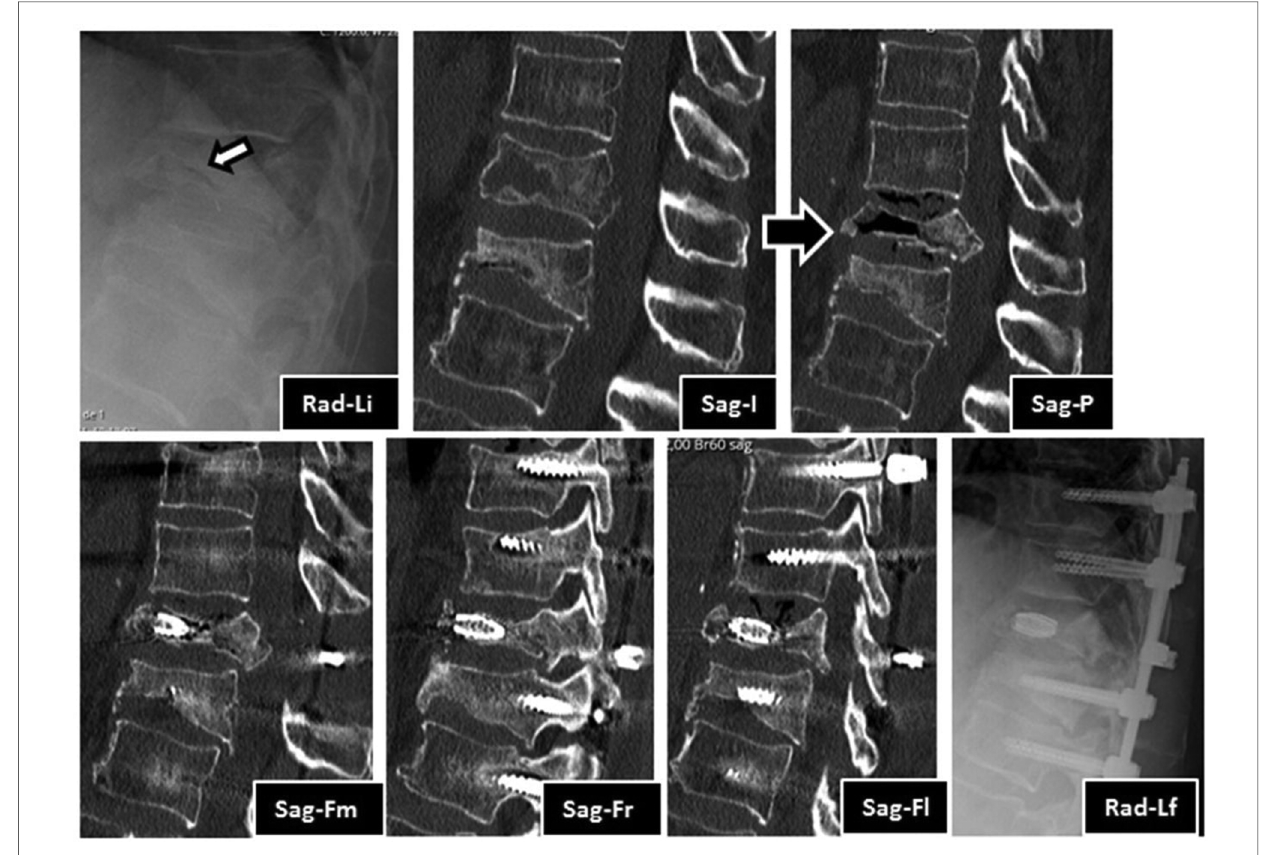
FIGURE 1 Imaging evolution of the clinical case in lateral view radiography images and sagittal CT sections: Rad-Li — initial radiograph in lateral view, showing T12 and L1 vertebral body fl atenning and extensive bone destruction at T12 (arrow); Sag-I — initial median sagittal view of computed tomography, showing acute T12 fracture and old L1 fracture. Note the extensive bone trabeculae destruction at anterior half of the vertebral body; Sag- P — Median sagittal view of tomography, showing T12 vertebral body pseudarthrosis with a large anterior intravertebral cleft and marked posterior wall retropulsion; Sag- Fm — Median sagittal view of CT at 1 year after surgery, showing T12 vertebral body pseudarthrosis fi lled with stent and signs of T12 laminectomy; Sag-Fr — Right parasagittal view of CT at 1 year after surgery, showing the right stent fi lled with bone graft and the right pedicular screws, note the pseudarthrosis healing; Sag-Fl — Left parasagittal view of CT at 1 year after surgery, showing the left stent fi lled with bone graft and the right pedicular screws. Note the pseudarthrosis healing; Rad-Lf — Final radiograph in lateral view at 2 years after surgery, showing T12 stents, adjacent pedicle screws, rods and